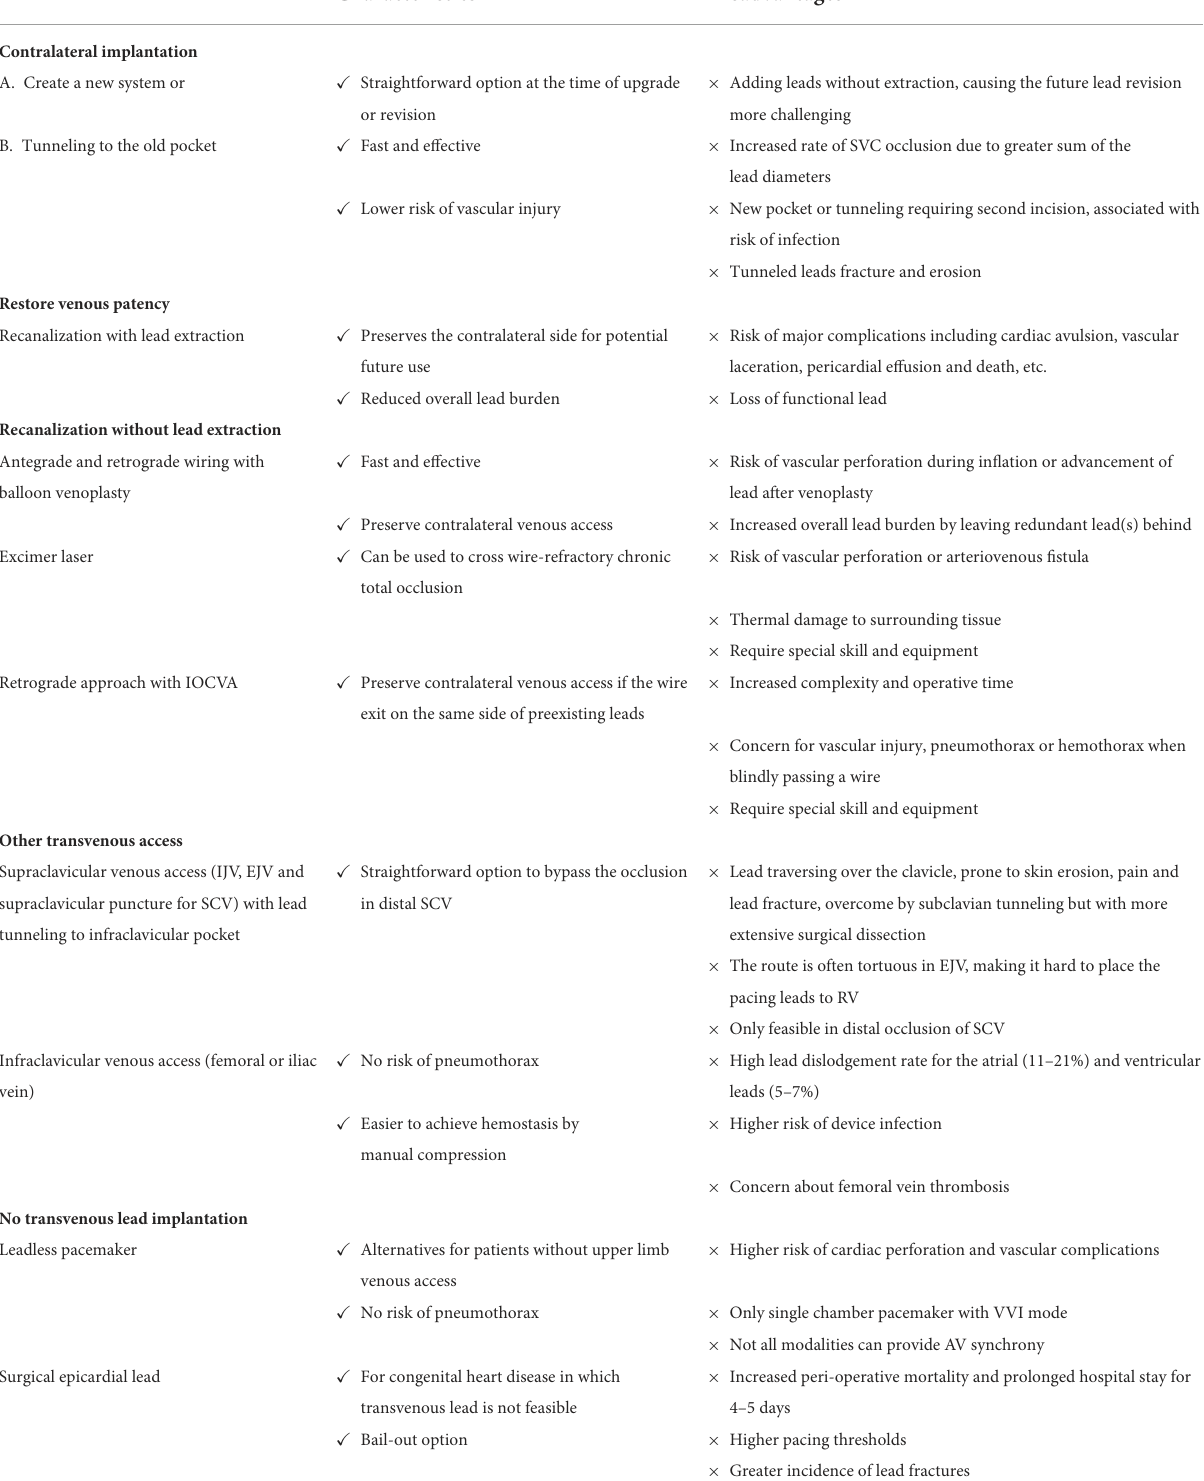
TABLE 1 Characteristics and disadvantages of strategies to overcome venous occlusion in lead implantation (7, 9, 13).